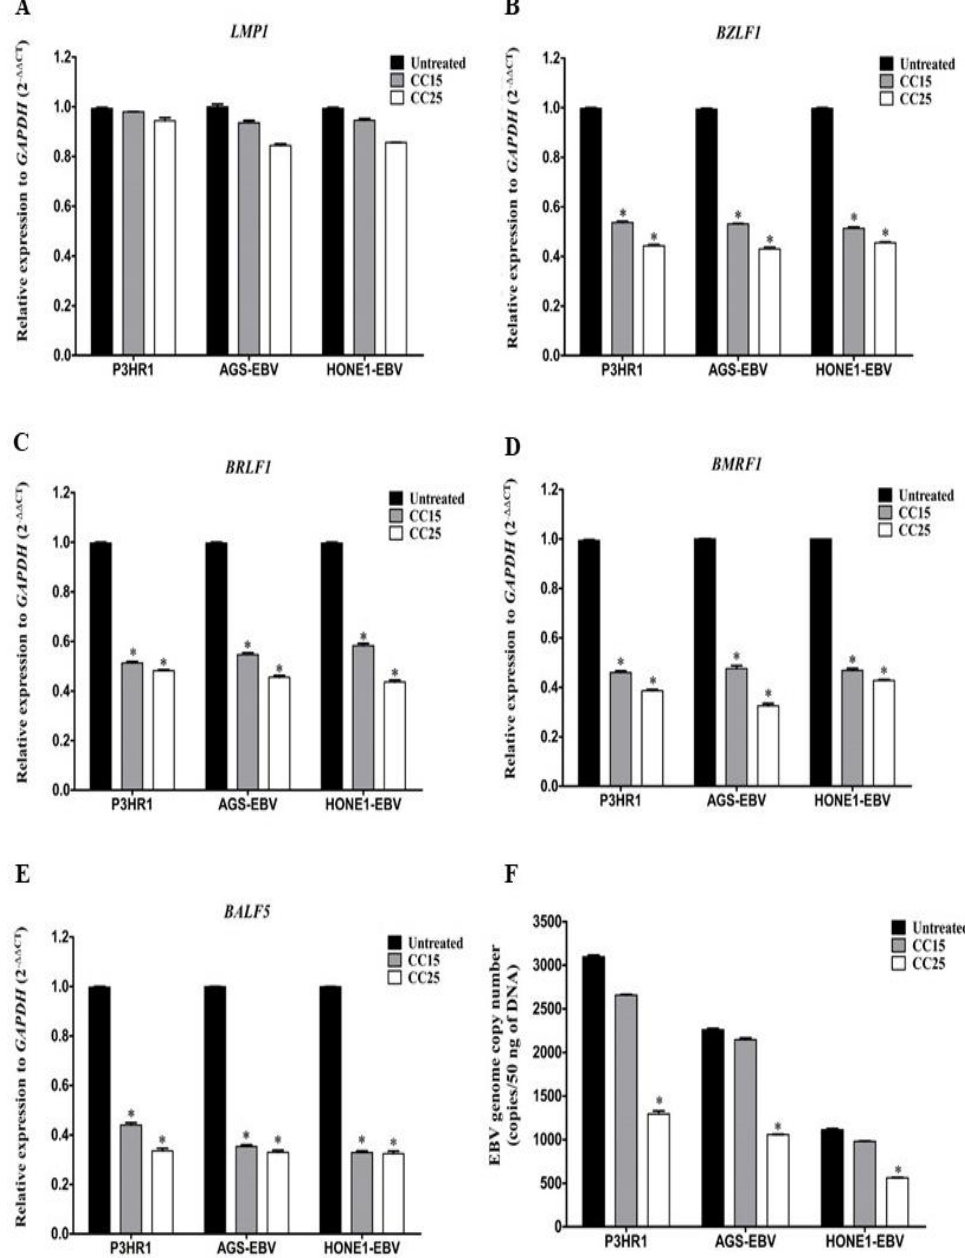
Figure 1. Andrographolide suppresses the spontaneous expression of EBV lytic genes. Cells were treated with various concentrations of andrographolide for 48 h. The expression of LMP1 ( A ), BZLF1 ( B ), BRLF1 ( C ), BMRF1 ( D ) and BALF5 ( E ) genes were analyzed by qRT-PCR. The quantification of EBV genome copy number ( F ) was performed by qPCR. *: p < 0.05.